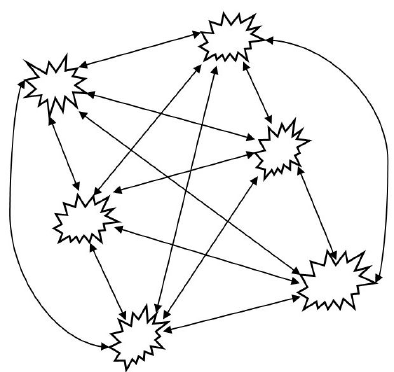
Figure 2. Architecture of an RNN for single flow in a six-output node